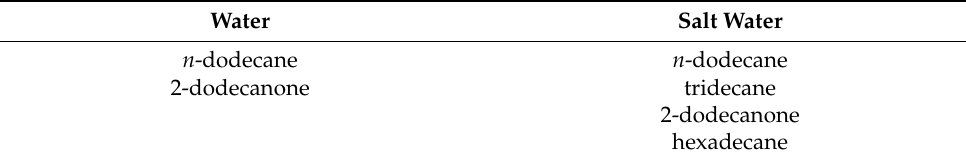
Table 1. Persistent compounds detected using the commercial PE stock in water or salt water after ~2 MGy of gamma irradiation.